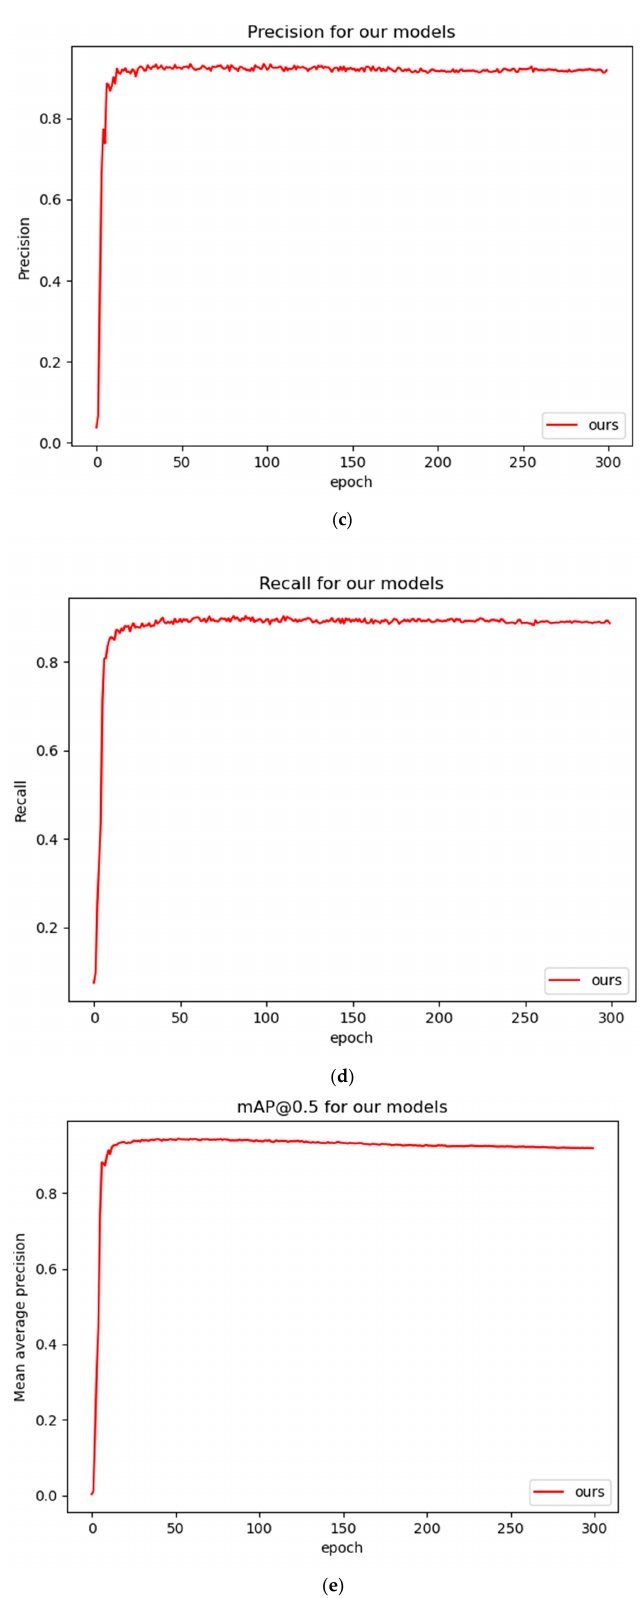
Figure 12. Training-process curves. ( a ) Training process: regression loss of bounding box, ( b ) training: confidence loss of bounding box, ( c ) precision, ( d ) recall, and ( e ) mean average precision.